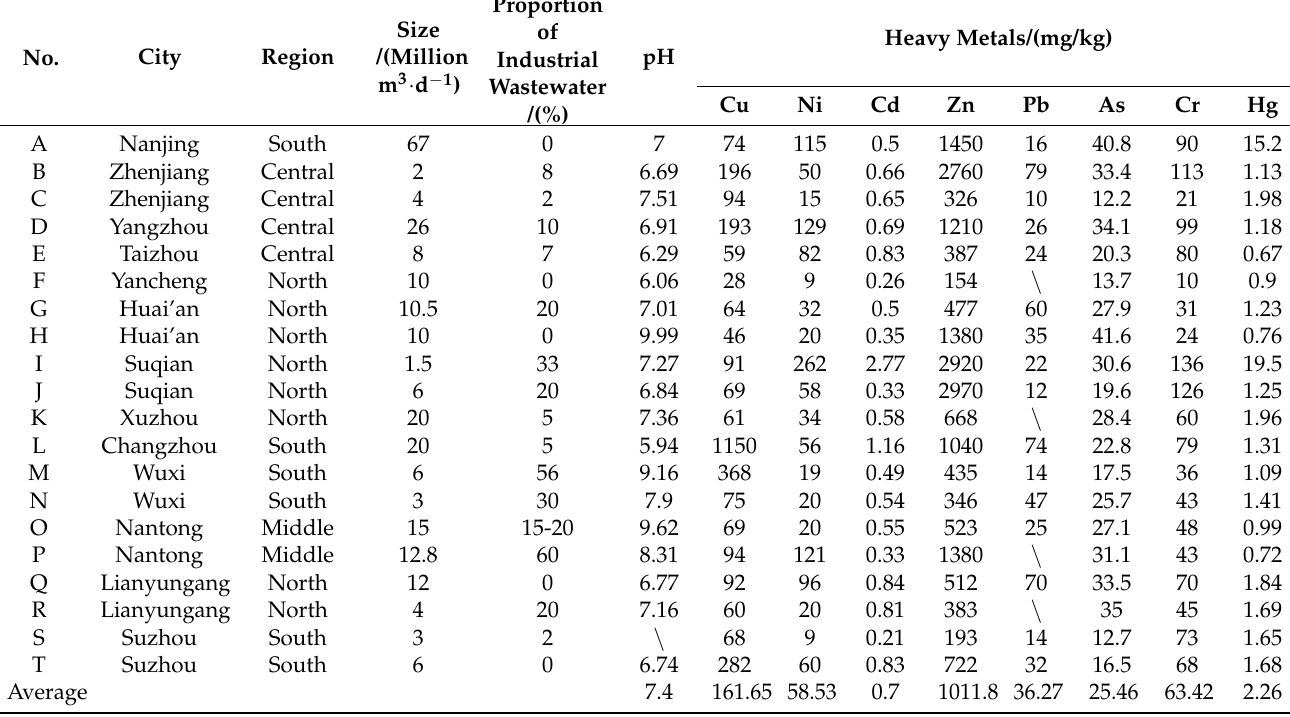
Table 1. Typical sludge concentration index of wastewater